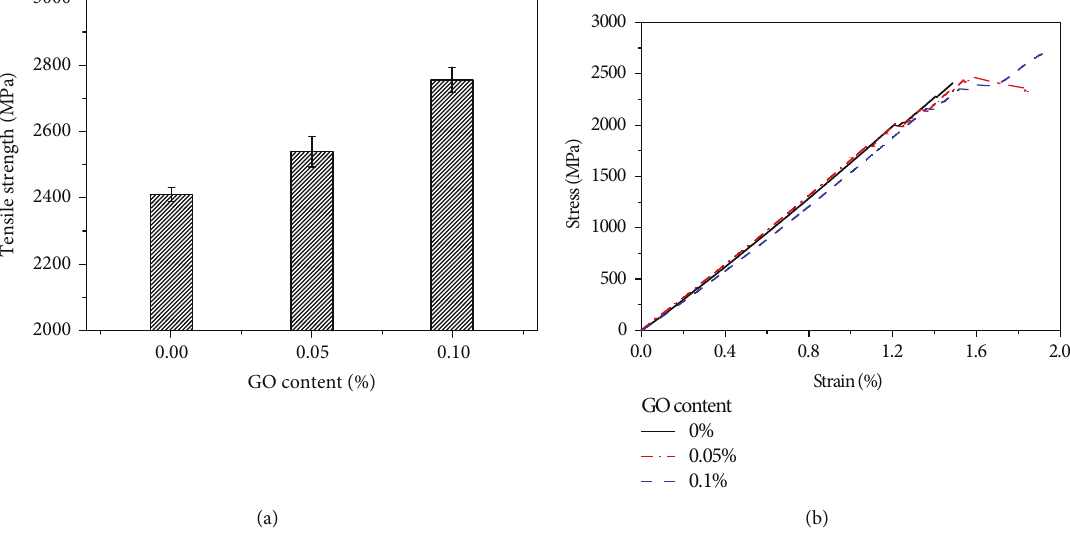
Figure 7: (a) variation in tensile strength and (b) stress vs. strain with the increased GO content in CFRP